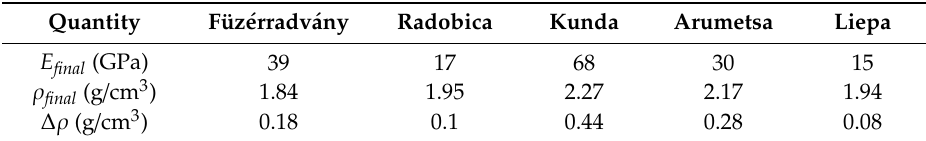
Table 4. The final values of Young’s modulus, the bulk densities, and the di ff erence between the final and initial bulk